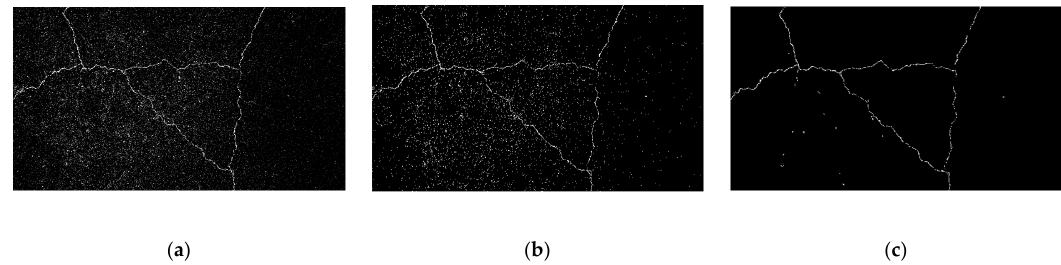
Figure 5. ( a ) Enhanced edge, ( b ) first-level binary, and ( c ) second-level binary images; defected dataset, spatial domain, and Prewitt filter.